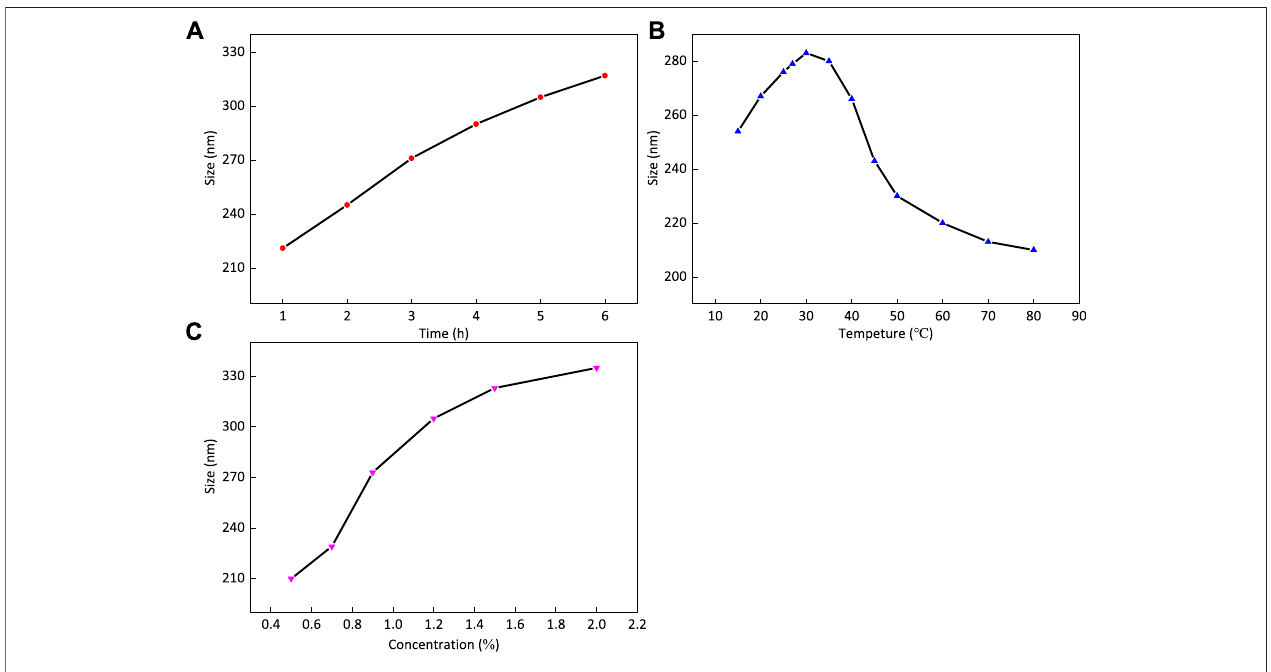
FIGURE 6 | Particle size of central magnetic core Fe 3 O 4 @SiO 2 is affected by reaction time (A) , reaction temperature (B) , and reactant concentration (C) .